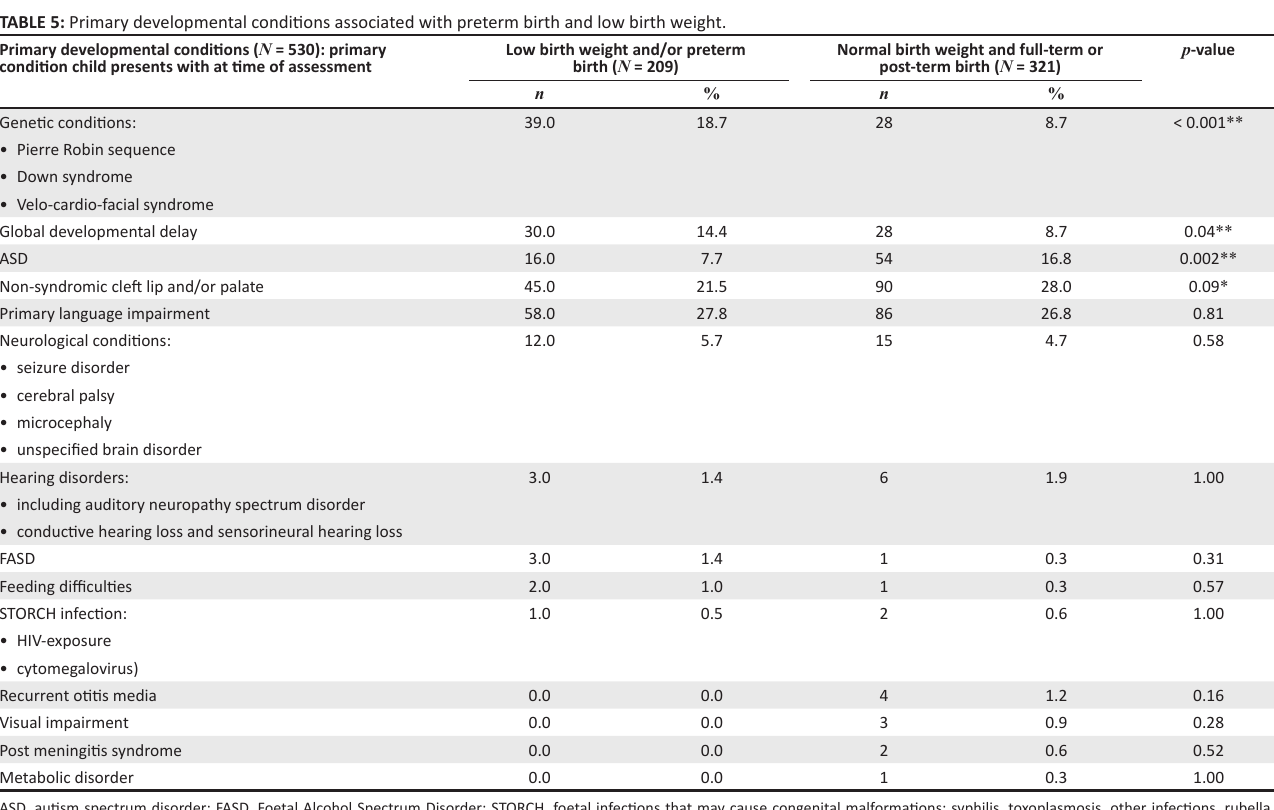
TABLE 5: Primary developmental conditions associated with preterm birth and low birth weight. Primary developmental conditions ( N = 530): primary condition child presents with at time of assessment